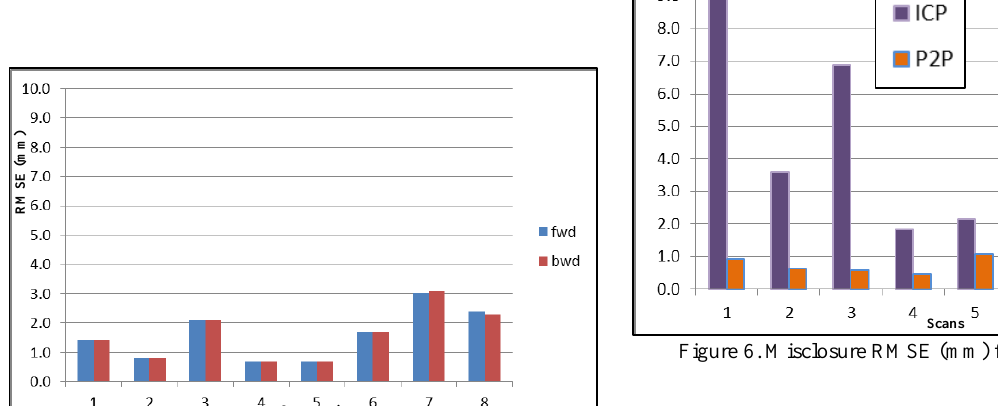
Figure 4. ICP registration RMSE (mm) for the eight scan pairs.